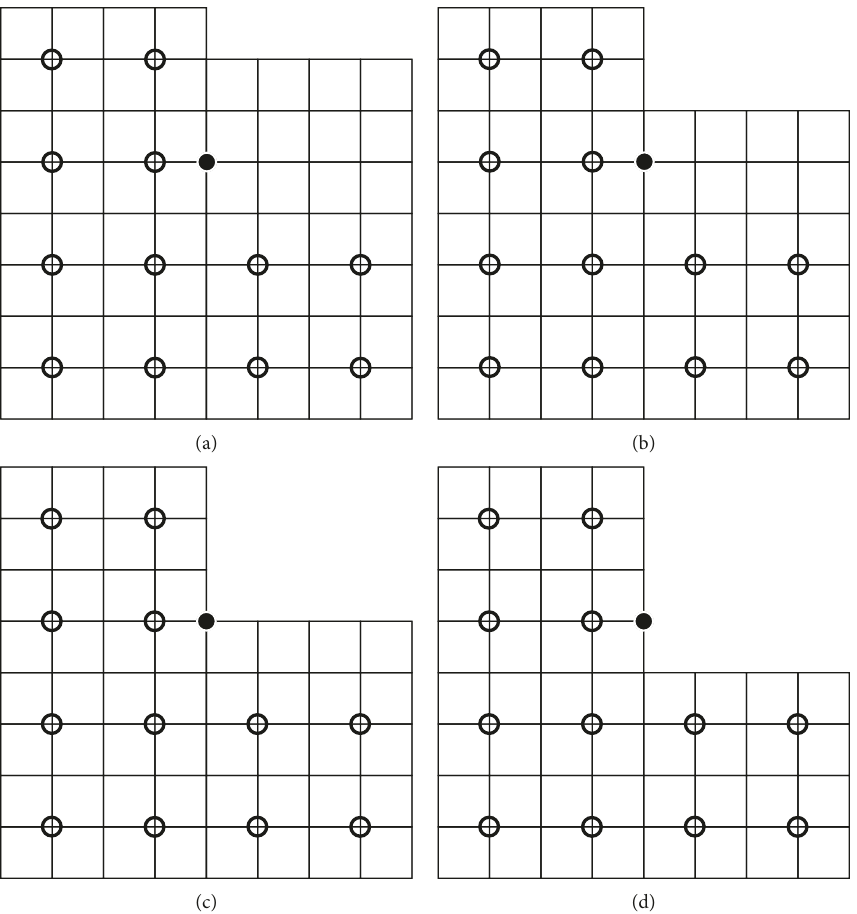
Figure 1: Finite element mesh and excavation sequence: 1st layer excavation (a), 2nd layer excavation (b), 3rd layer excavation (c), and 4th layer excavation (d) (circles indicate 12 displacement measurement locations, and the dot indicates the target node where uncertainties in displacements are to be